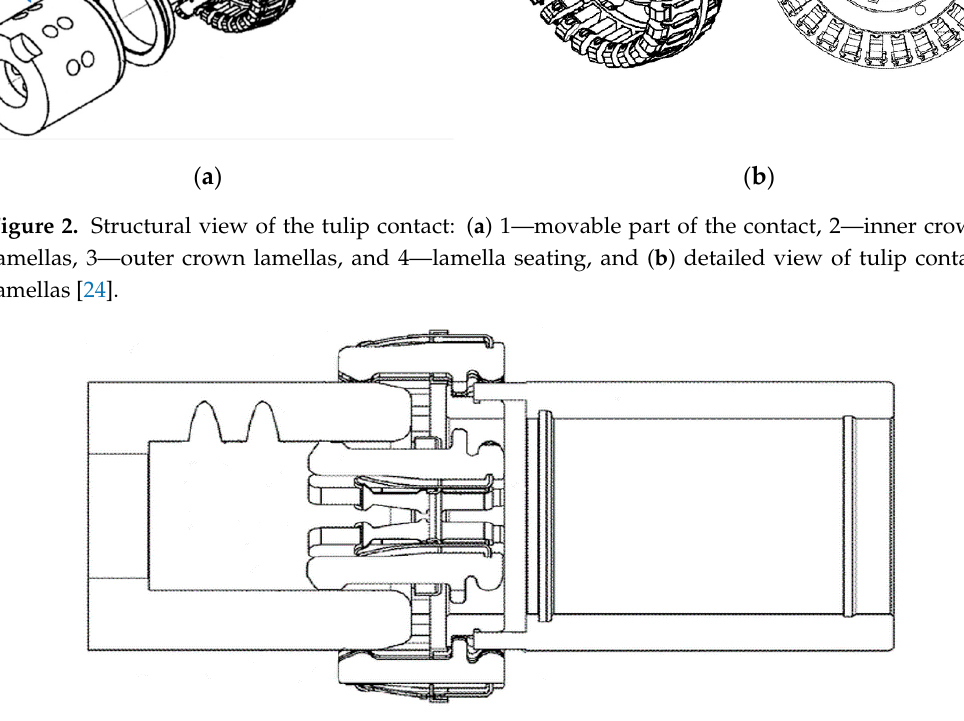
Figure 3. Longitudinal section of a closed tulip contact [24].